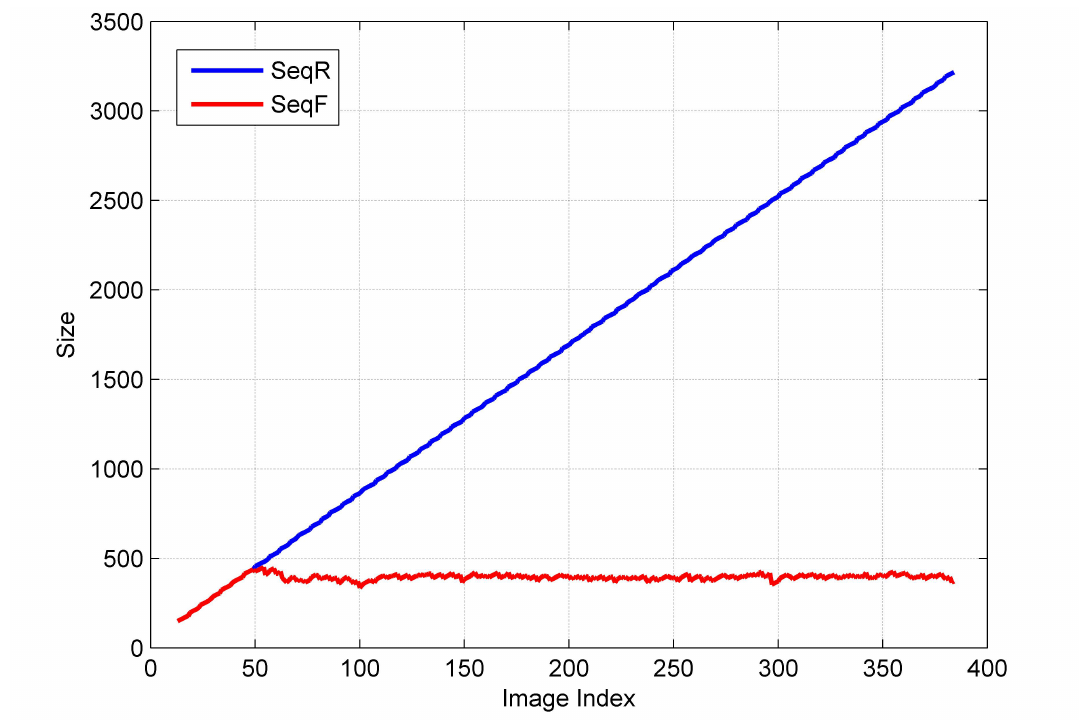
Figure 11. Size of parameter